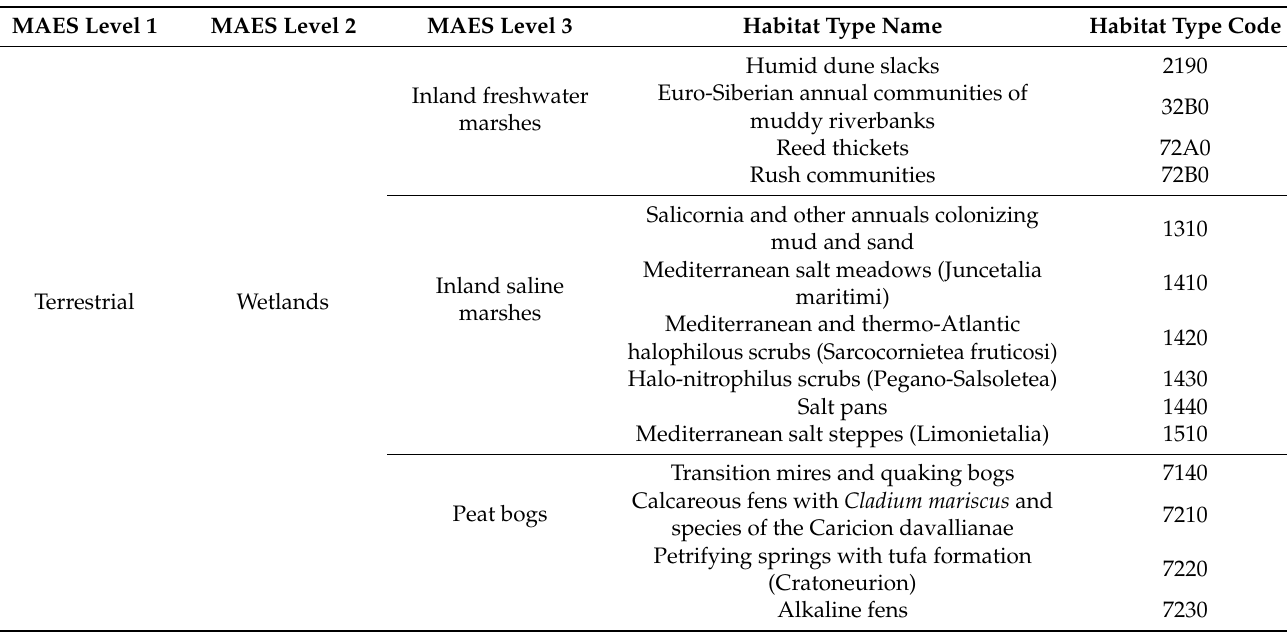
Table 1. Typology example of the correspondence among mapping and assessment of ecosystems and their services (MAES) ecosystem type classes (level 1, 2 and 3) and habitat types, for the